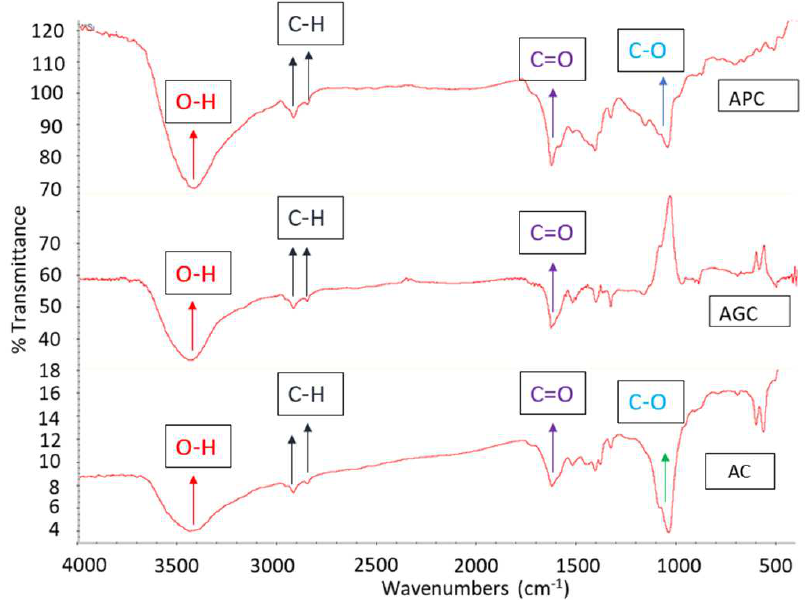
Figure 1. FTIR spectra of AC, AGC, and APC.